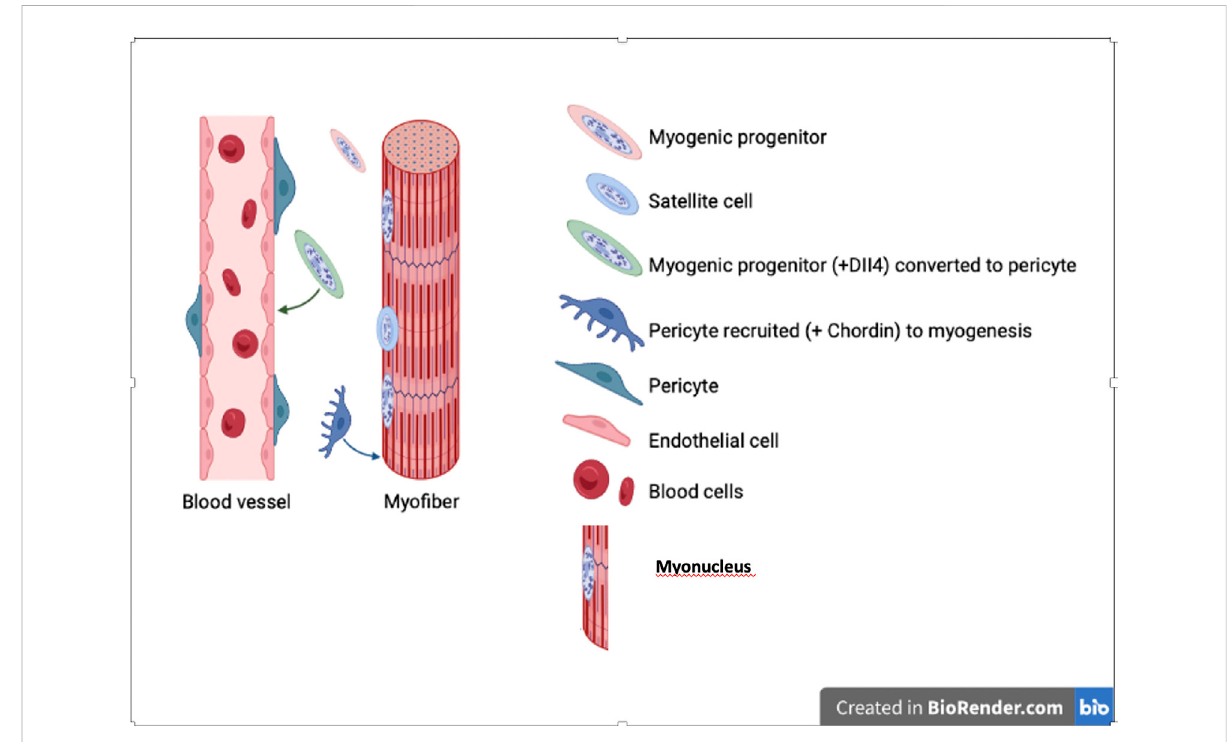
FIGURE 4 Bi-directional differentiation of myogenic cells into pericytes and vice versa . Myogenic cell nuclei are represented in salt and peper gray, while nuclei of non myogenic cells in uniform solid